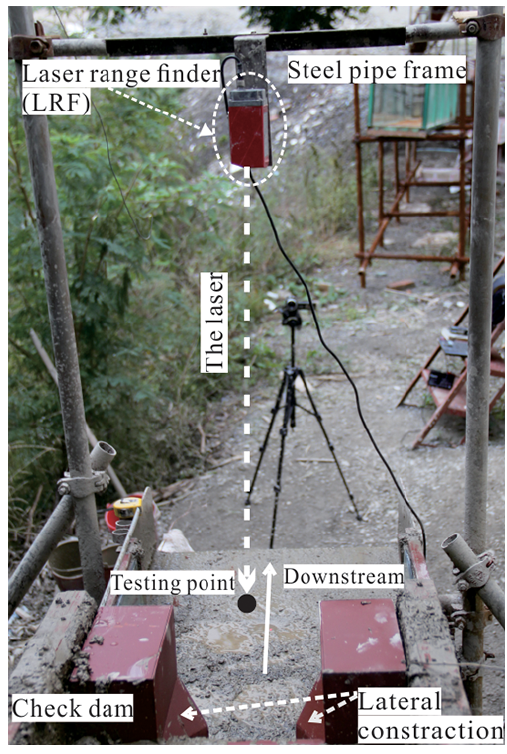
Figure 4. Photograph of the LRF system (the photograph was taken in the downstream direction).